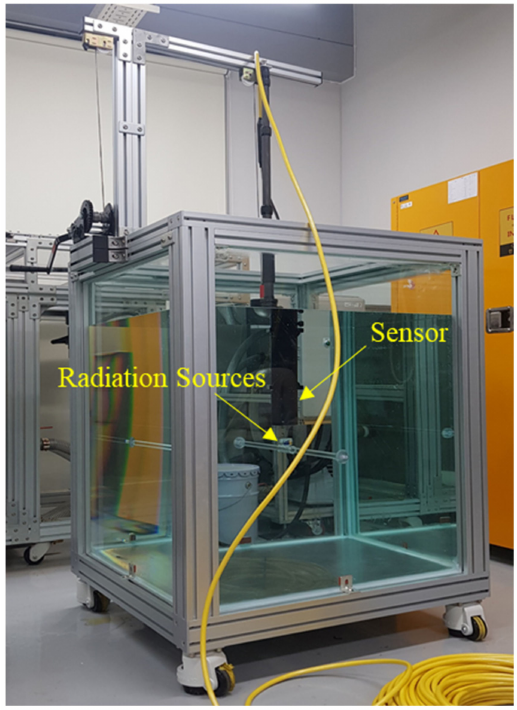
Figure 4. Water tank used for sensor